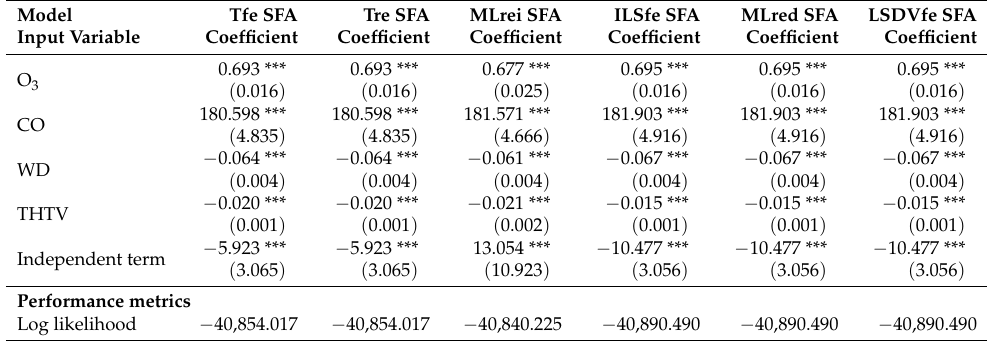
Table 9. Outcomes of time-variant models for stochastic frontier